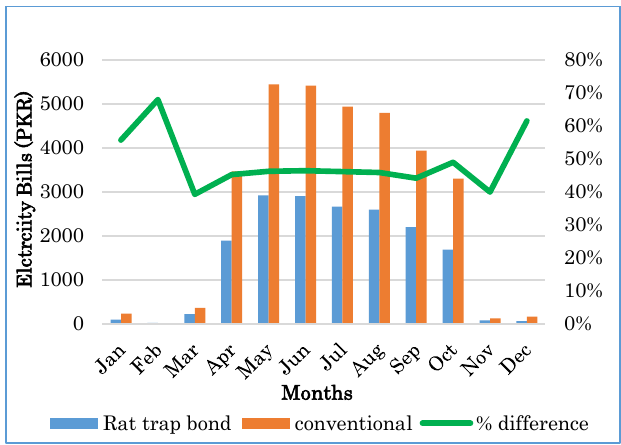
Fig. 5. Electricity cost comparison of rat trap